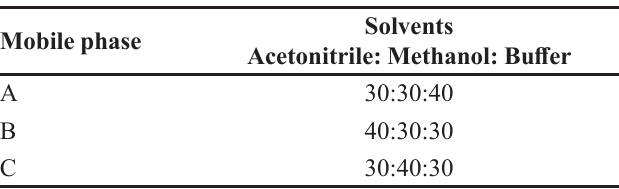
TABLE I - Different compositions of mobile phase at pH